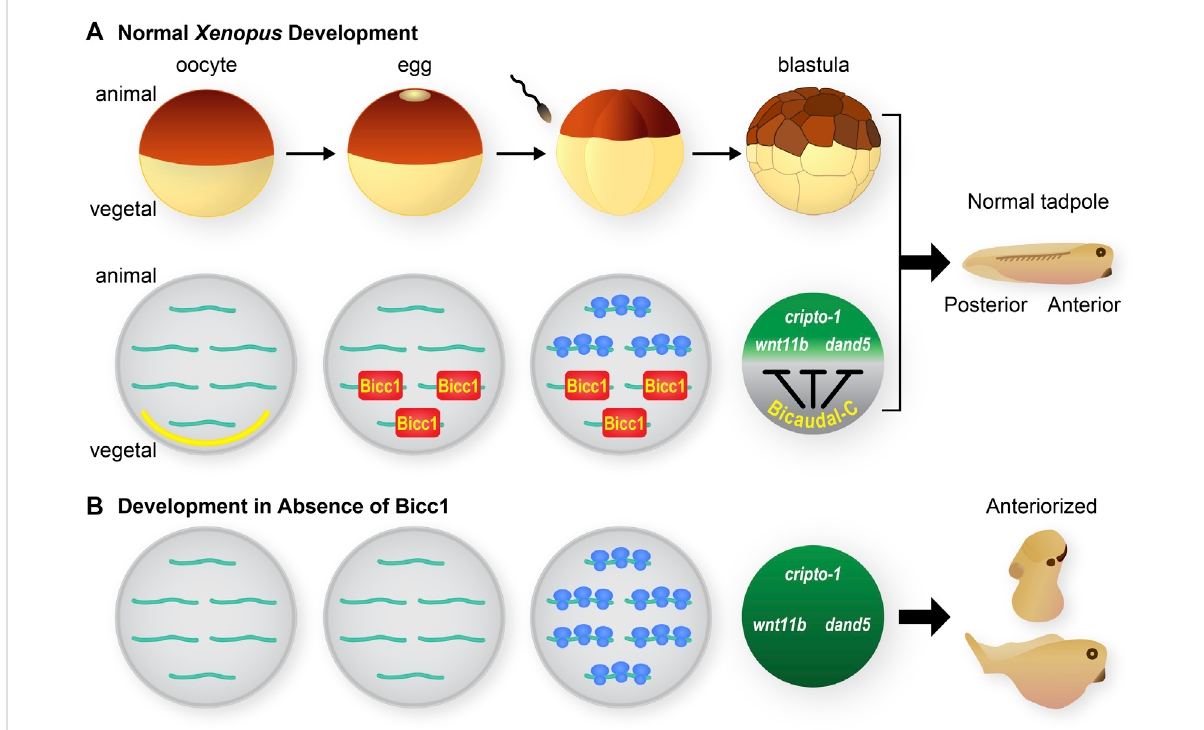
FIGURE 2 Xenopus Bicaudal-C, regulator of maternal mRNA translation and cell fates (A) The diagram at the top depicts the early stages of Xenopus development.Oocytesmatureinto eggs thatarecompetent tobefertilized.Following fertilizationtheembryos undergoes aseries ofrapid cleavage divisions to generate blastula stage embryos. The initial stages of embryonic development occur in the absence of zygotic transcription and rely on the regulated use of maternal mRNAs and proteins. During normal development bicc1 mRNA is localized to the vegetal cortex of fully-grown oocytes (yellow section at vegetal pole) (Wessely and De Robertis, 2000). During oocyte maturation the bicc1 mRNA is released from thecortex and atthesametimebecomestranslationallyactivetogenerateBicc1protein(Parketal.,2016).Bicc1proteinisdistributedinavegetaltoanimalgradient inembryos where itbinds to speci fi cmRNAsand represses their translation. Severalofthese target mRNAs ( cripto-1 , wnt11b and dand5 )encodecell fate regulatory proteins. Bicc1 normally modulates the synthesis of these proteins and their activities contribute to the formation of a tadpole with anterior-posterior polarity. (B) Development in the absence of Bicc1. To create embryos that lack Bicc1 oocytes are injected with anti-sense oligonucleotides to speci fi cally degrade the Bicc1 mRNA. Treated oocytes are matured and then converted to embryos using the host transfer technique (Park et al., 2016). Bicc1 target mRNAs are translated inappropriately in embryos depleted of Bicc1 and the encoded proteins accumulate tohigherlevels.AsaconsequenceBicc1depletedembryosdevelopintotadpoleswithanexcessofanteriorcelltypesandstructures – ananteriorized phenotype (Park et al., 2016).